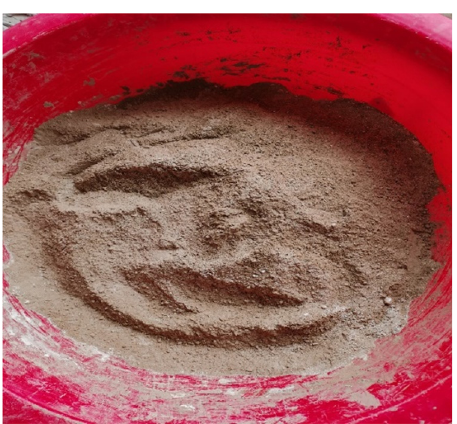
Figure 4: Yellow mud of Qiang Village.